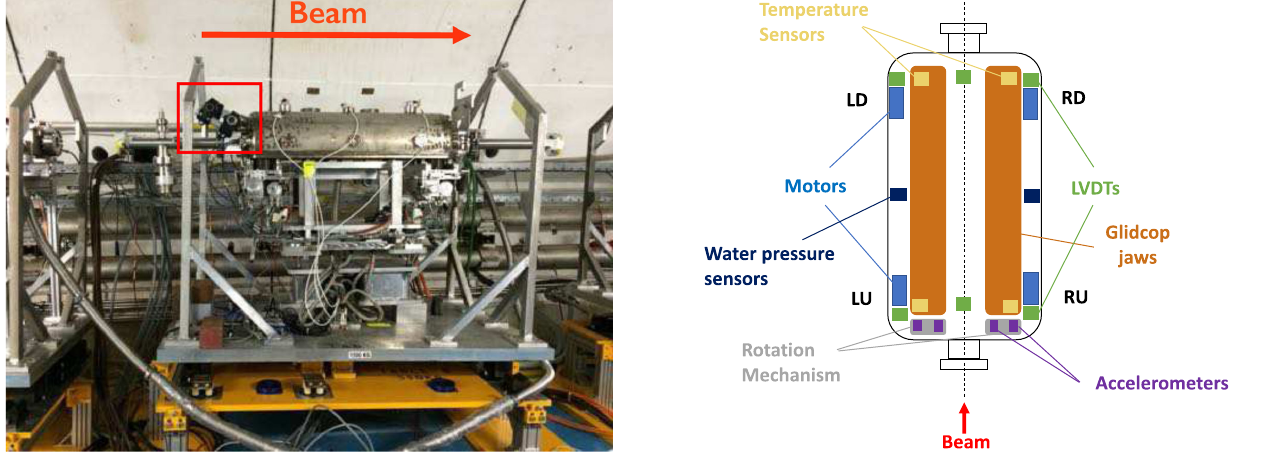
FIG. 12. Installation of the rotatable collimator prototype on the HiRadMat experimental table in the tunnel, showing the beam direction and the location of the radiation-hard camera.